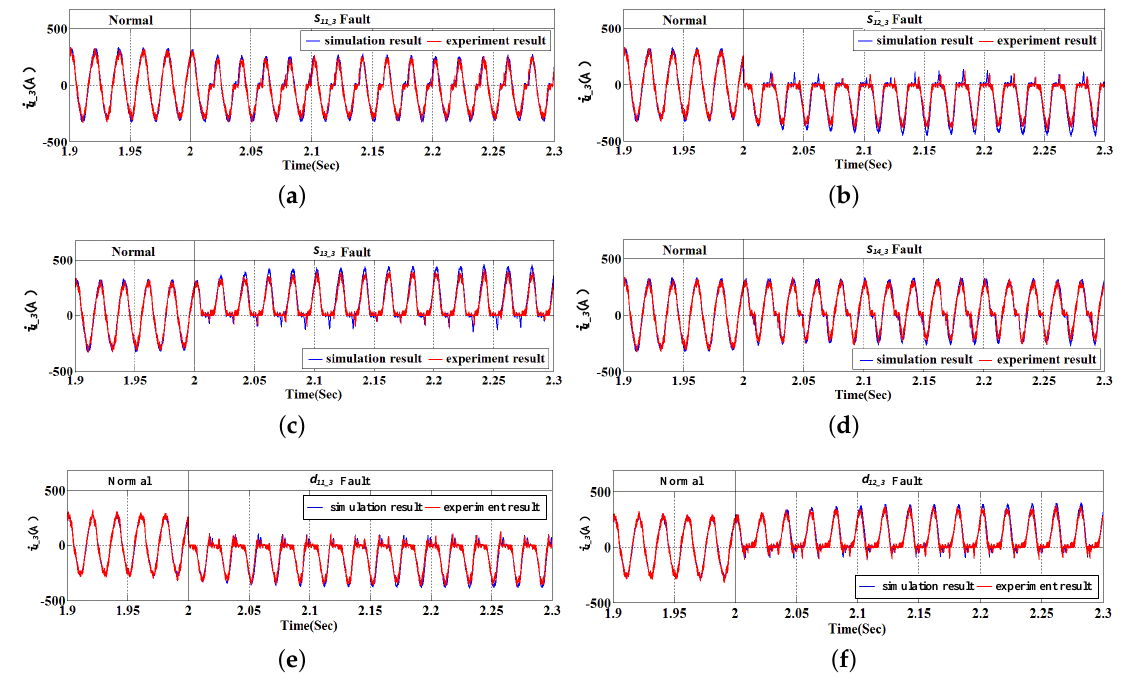
Figure 10. Results of open-circuit faults happening in the first